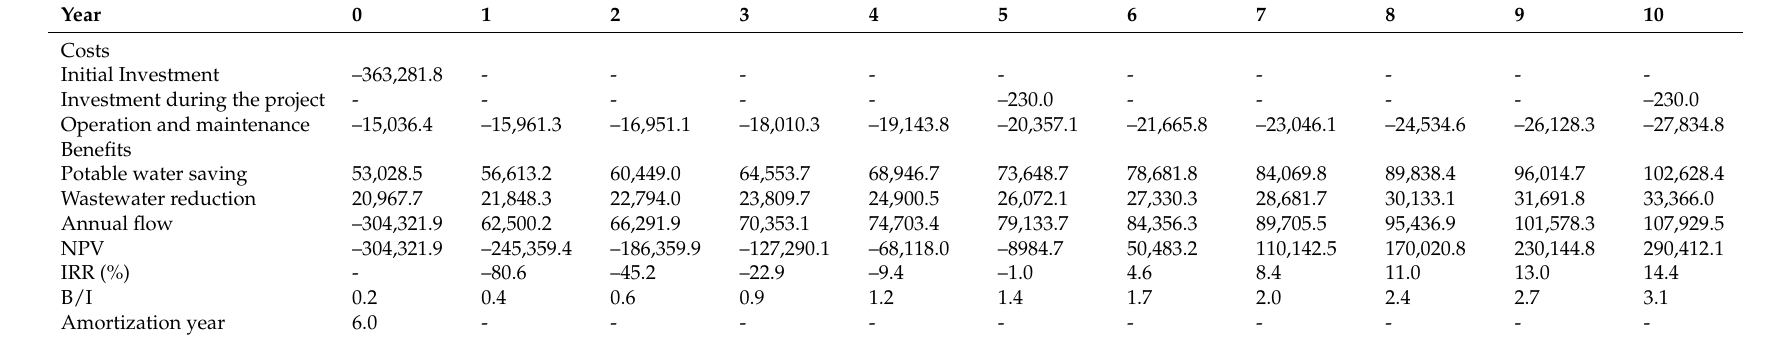
Table 10. Cash flow for implementing the systems for rainwater harvesting and greywater treatment and reuse on Monterrey Campus (US $). Year 0 Costs Initial